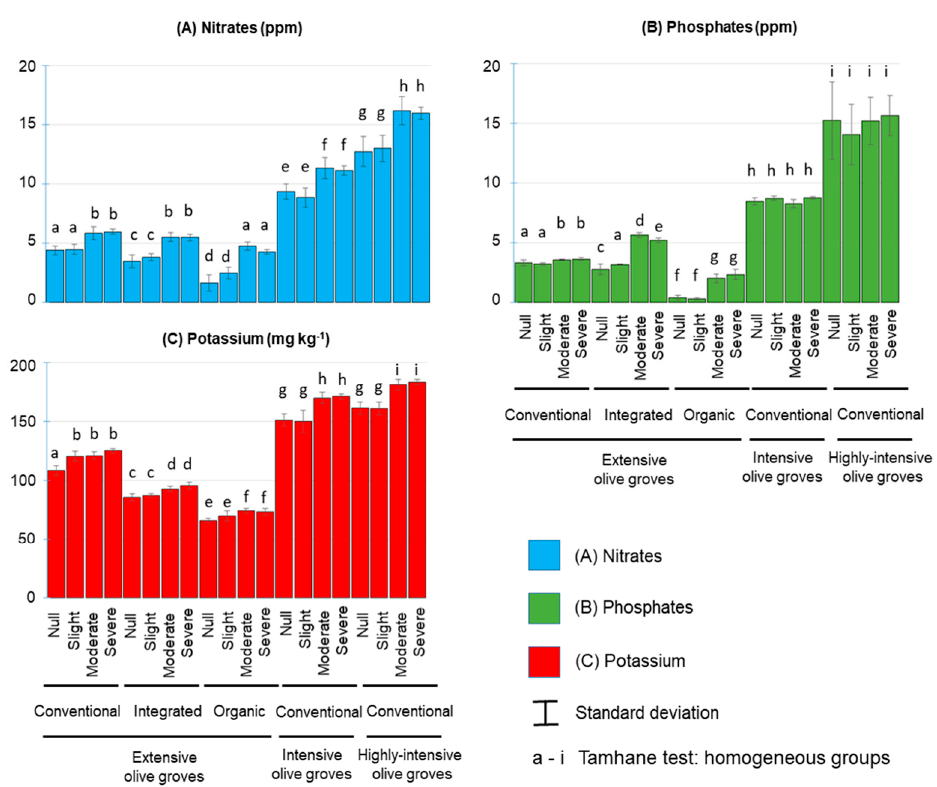
Figure 3. Mean values and standard deviations for each soil fertilizer: ( A ) nitrates (ppm); ( B ) phosphates (ppm); and ( C ) potassium (mg kg − 1 ) for each soil erosion level and type of olive grove. Indexes, a–i, indicate the classification groups generated in the Tamhane post-hoc test to establish similar categories.